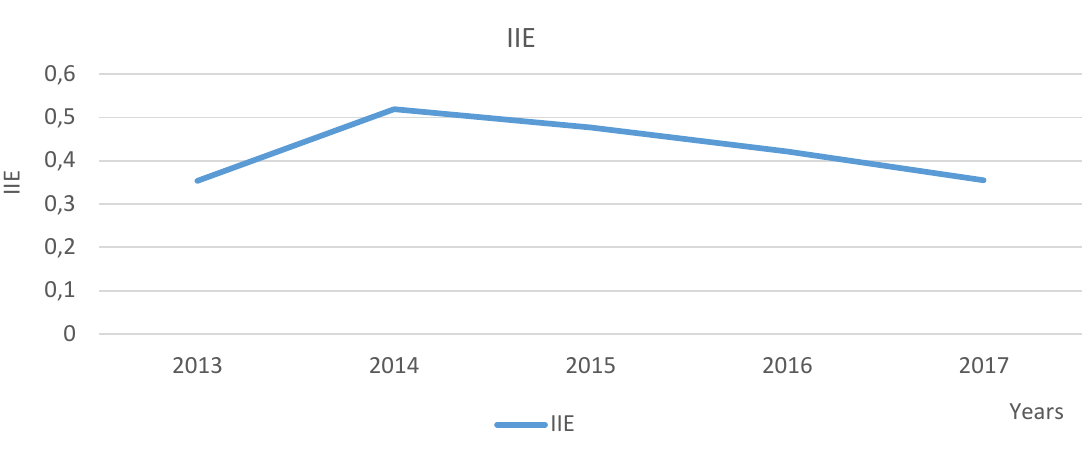
Figure 2. Dynamics of the general level of development of export-import activity of PAT